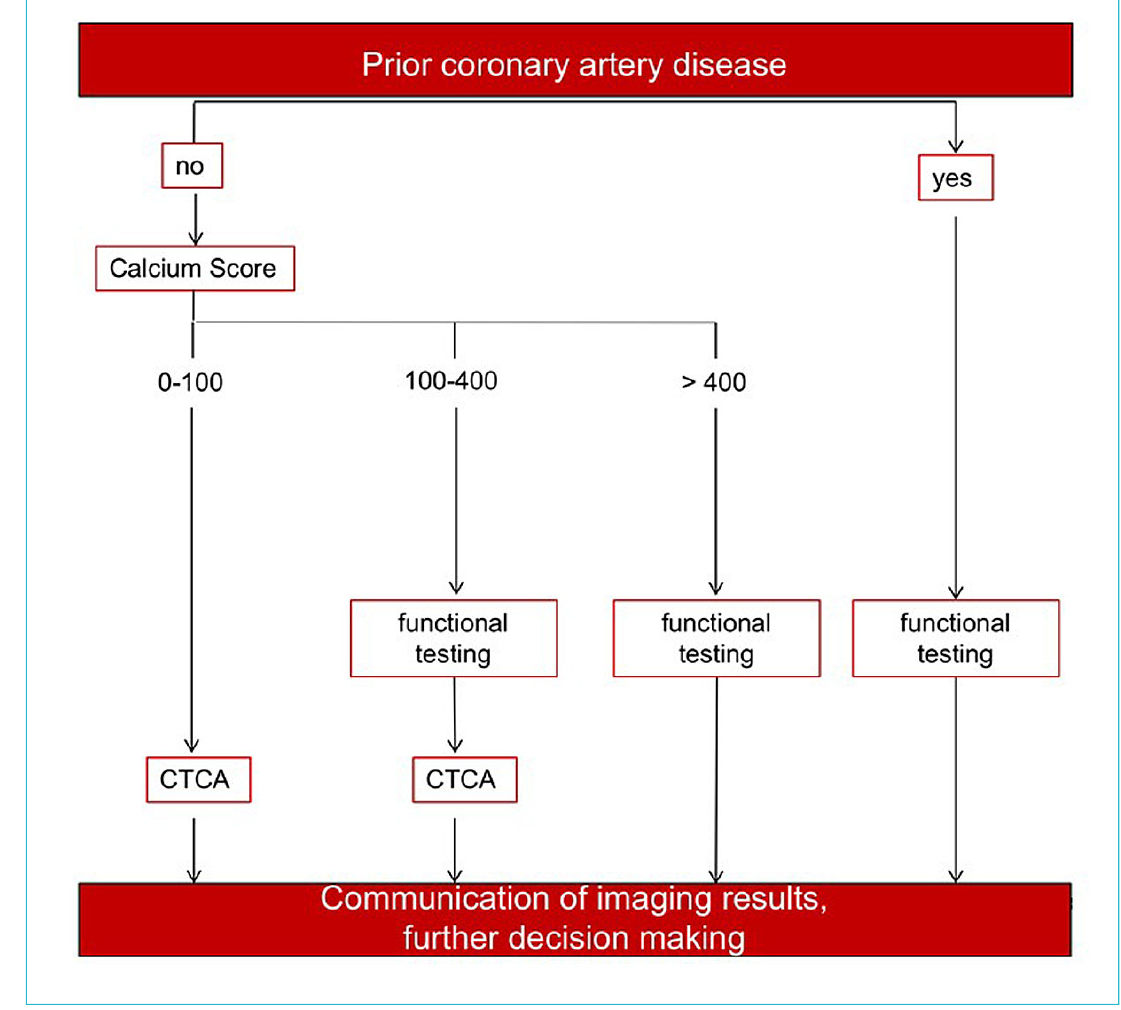
Figure 4: Suggestion of an efficient patient tailored approach for coronary artery disease (CAD) risk stratification using hybrid techniques. In patients with an intermediate pretest probability of disease, the CAD evaluation could be tailored according to this